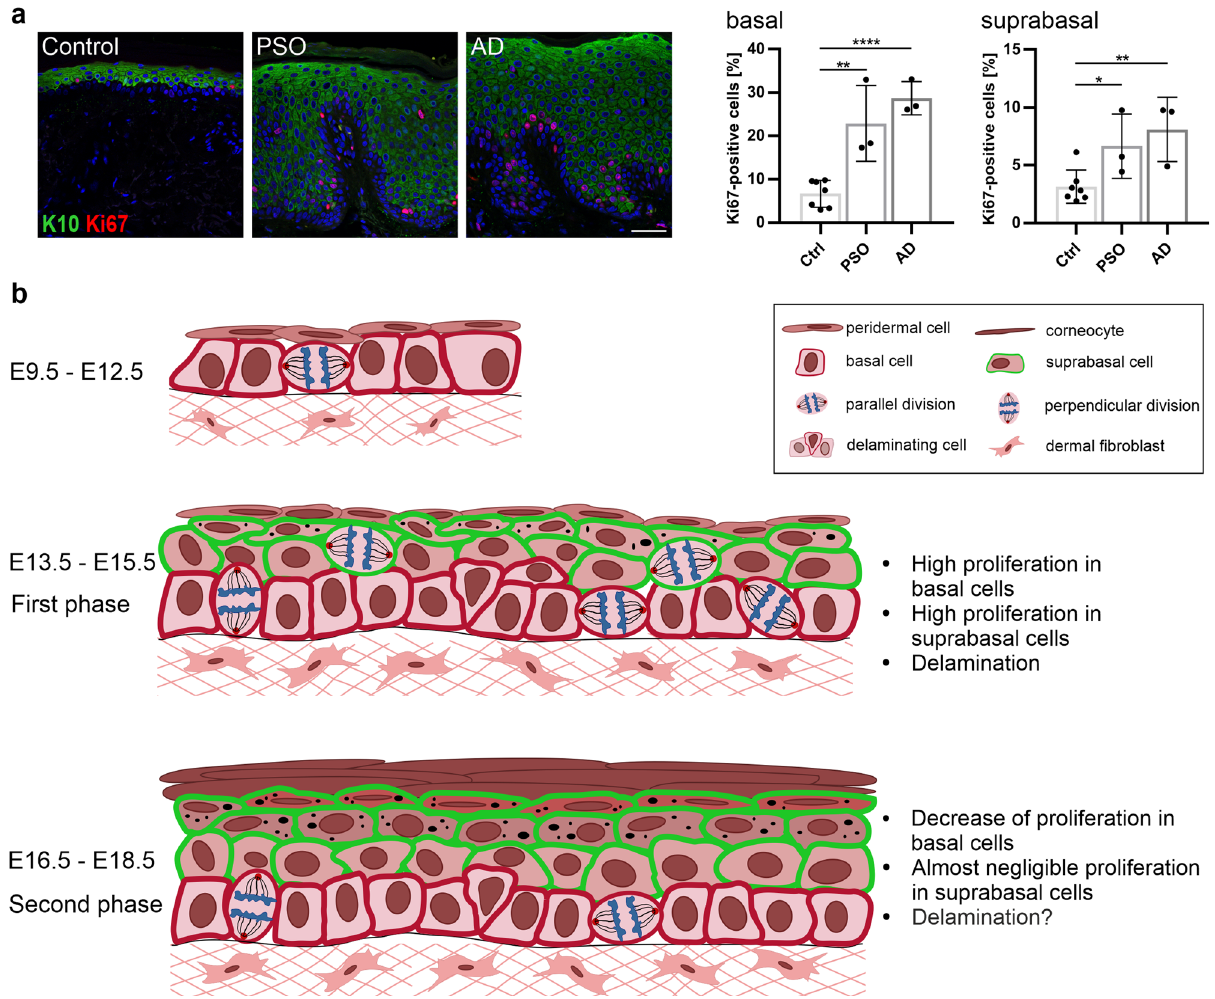
Fig. 7 The human epidermis harbors a proliferative suprabasal population and a proposed model of mouse skin epidermal development. a Immunostaining of Control ( n = 7), psoriasis (PSO) ( n = 3) and atopic dermatitis (AD) ( n = 3) human skin samples for Ki67 (red) and K10 (green) (scale bar: 50 µ m), and quanti fi cation of the percentage of Ki67-positive cells in the basal and suprabasal layers. * p < 0.05, ** p < 0.01, **** p < 0.0001 (two-tailed student ’ s T -test). Bars represent mean ± SD. b An illustration of the model for mouse skin epidermal development. The simple-like epithelium between E9.5 – E12.5 undergoes its main strati fi cation events during the fi rst phase between E13.5 – E15.5, where both basal and suprabasal keratinocytes have high proliferation/division rates and basal cells delaminate to fuel strati fi cation. In the second phase between E15.5 – E18.5, proliferation rates are